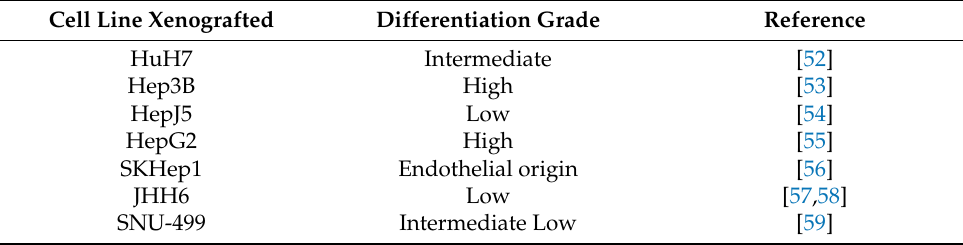
Table 2. HCC cell lines employed to generate HCC xenograft zebrafish